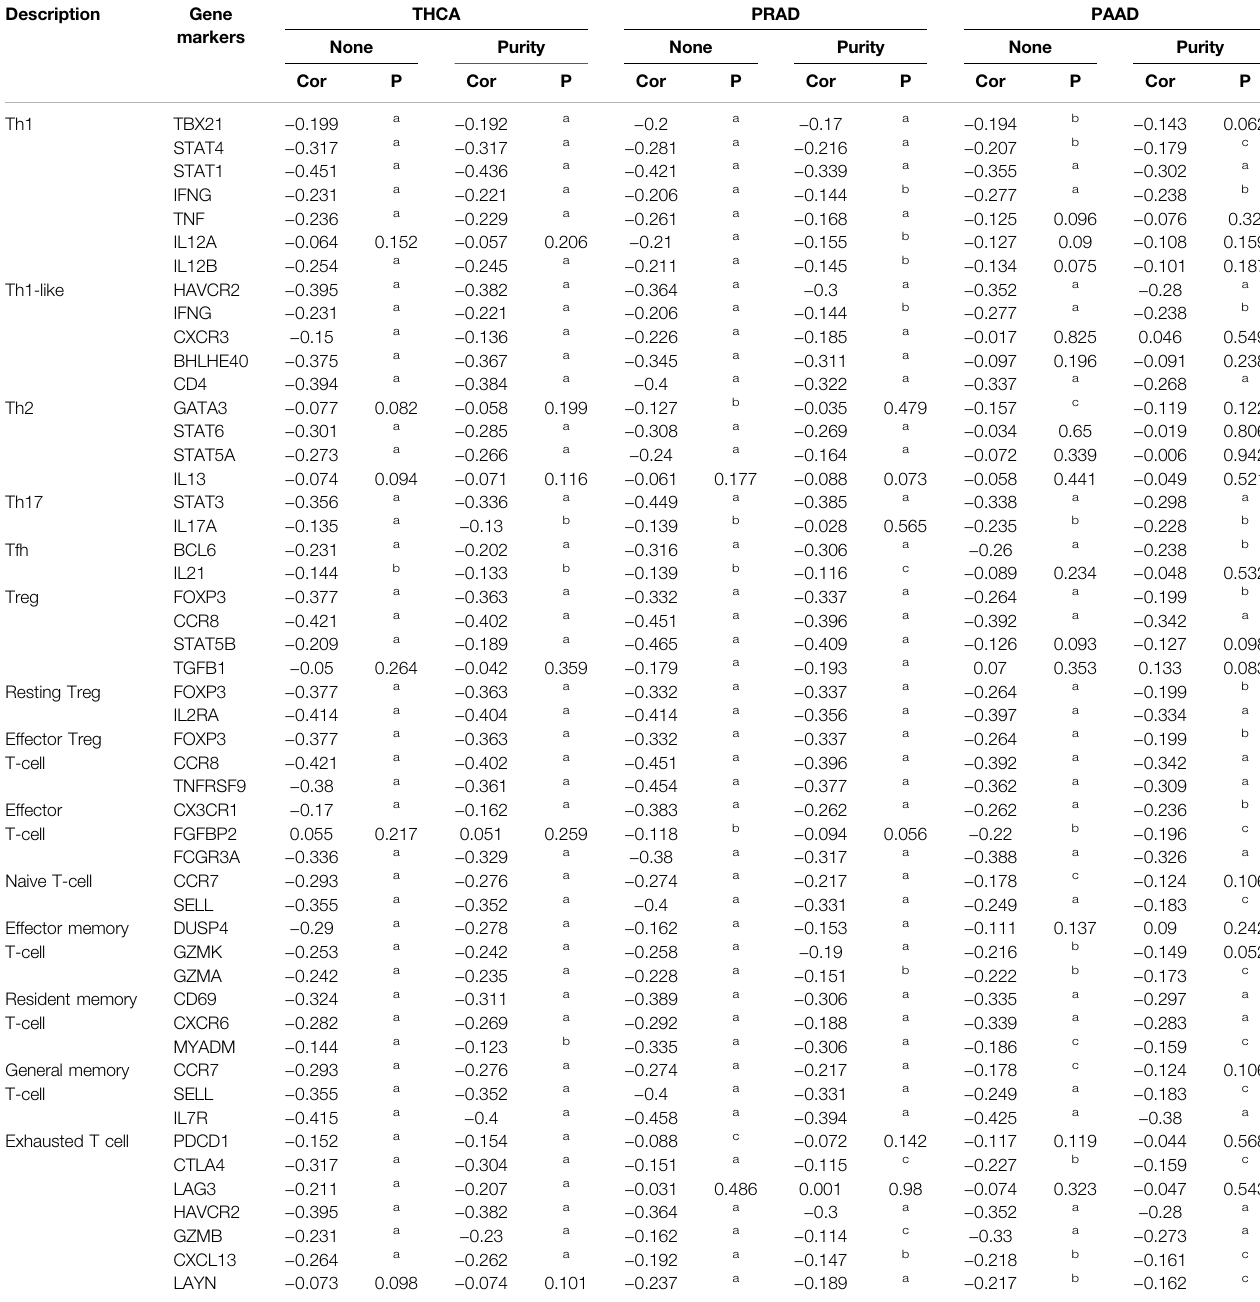
TABLE 2 | Correlation analysis between ALKBH7 and gene markers of different types of T cells in TIMER. Description Gene